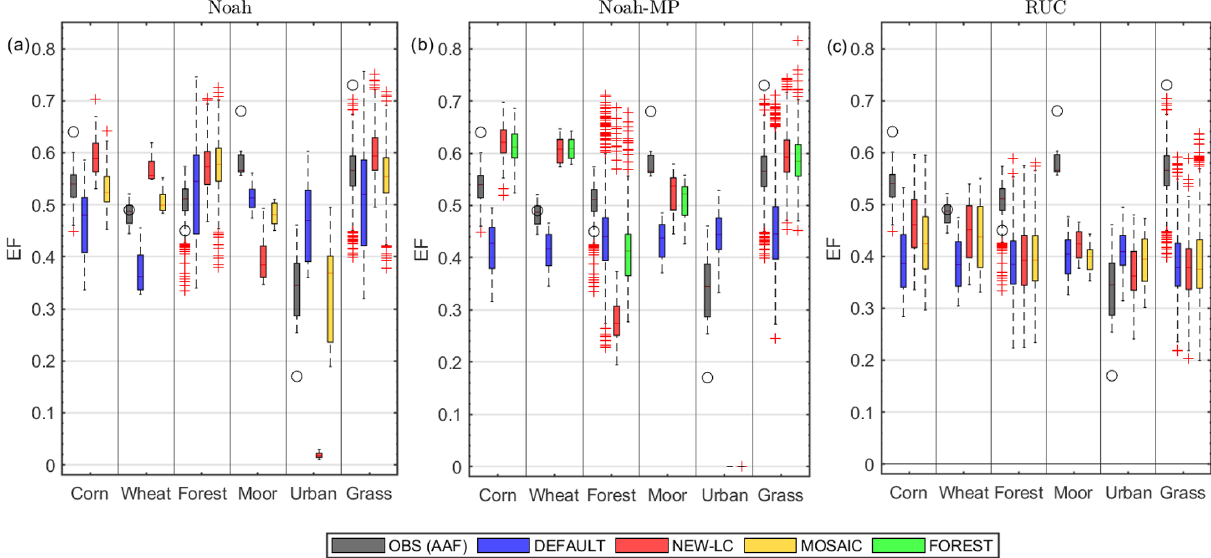
Figure 11. Evaporative fraction (EF = Le /( SH + Le ) ) for the different LSMs used: (a) Noah, (b) Noah-MP, and (c) RUC. The results are ordered by the real dominant LC type of the pixels (vertical subdivisions) and for the different experiments performed: DEFAULT (blue), NEW-LC (red), MOSAIC (orange, only in Noah and RUC), and FOREST (green, only in Noah-MP). The values obtained from the observations (AAF) are indicated with dark-grey box plots. Black circles indicate the EF obtained from the EC towers for each corresponding (homogeneous)